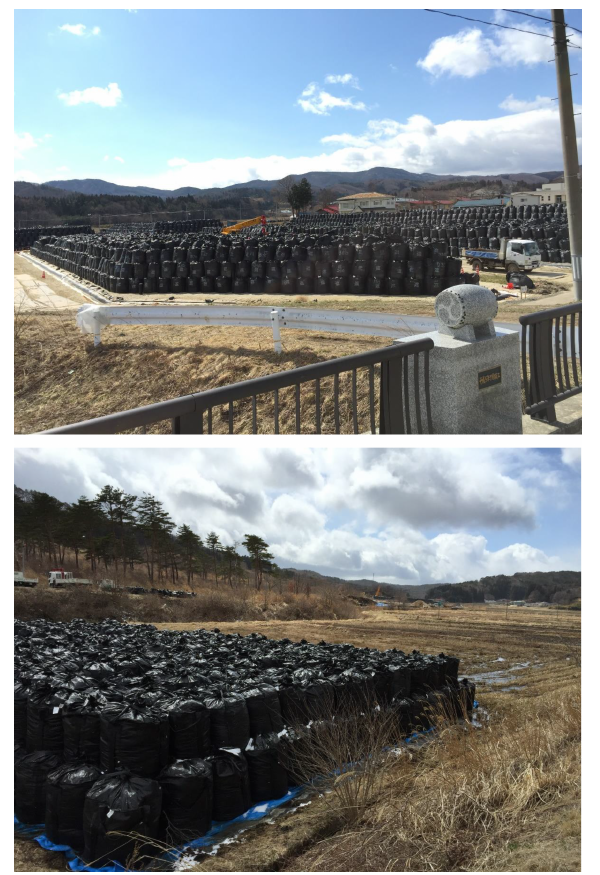
Figure 6. Temporary storage facilities for radioactive waste in Iitate village, in the Fukushima